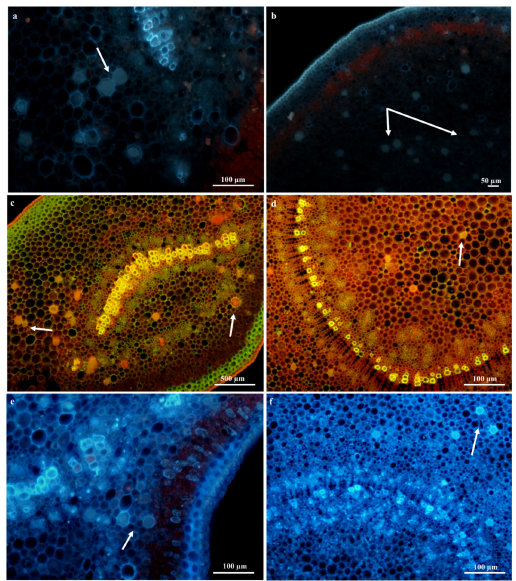
Figure 9. Fluorescence microscopy of young leaf midrib and young stem sections of T. ventricosa . ( a ) Auto-fluorescence of laticifer cell in leaf section showing intense blue fluorescence indicating the presence of phenolics. ( b ) Positive auto-fluorescence stain of stem section indicative of phenolics. ( c , d ) Leaf and stem sections stained orange-red using Acridine Orange indicating non-lignified laticifer contents. ( e , f ) Positive staining for cellulose using Calcofluor White on leaf and stem sections. Arrows refer to laticifer. 2.5. Laticifer Ultrastructure of Adult Plant Leaves Due to the difficulty experienced in the ultrastructural analyses of embryos, seedlings, and adult stems, only young leaf material was used for ultrastructural investigations. The laticifer system in the young leaves of T. ventricosa was formed by the accumulation of new cells, accompanied by a rapid discontinuity of transverse cell walls, resulting in the combination of their protoplasts (Figure 10). These ultrastructural changes have been similarly observed in other latex bearing species [18,31,33]. These cells were notable from surrounding ground and vascular tissue by contact with adjacent cells via cell wall dissolution (Figure 10c), irregularly thickened cell walls (Figure 10e), latex content (Figure 10c and Figure 11c,d) and their lengthened form (Figure 11a), similarly observed in other studies [18,31]. Irregularly shaped laticifers displaying acuminate ends (acute apex) were found